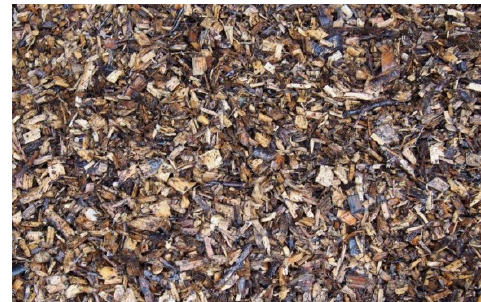
Fig. 3. Tested material – green wood chips